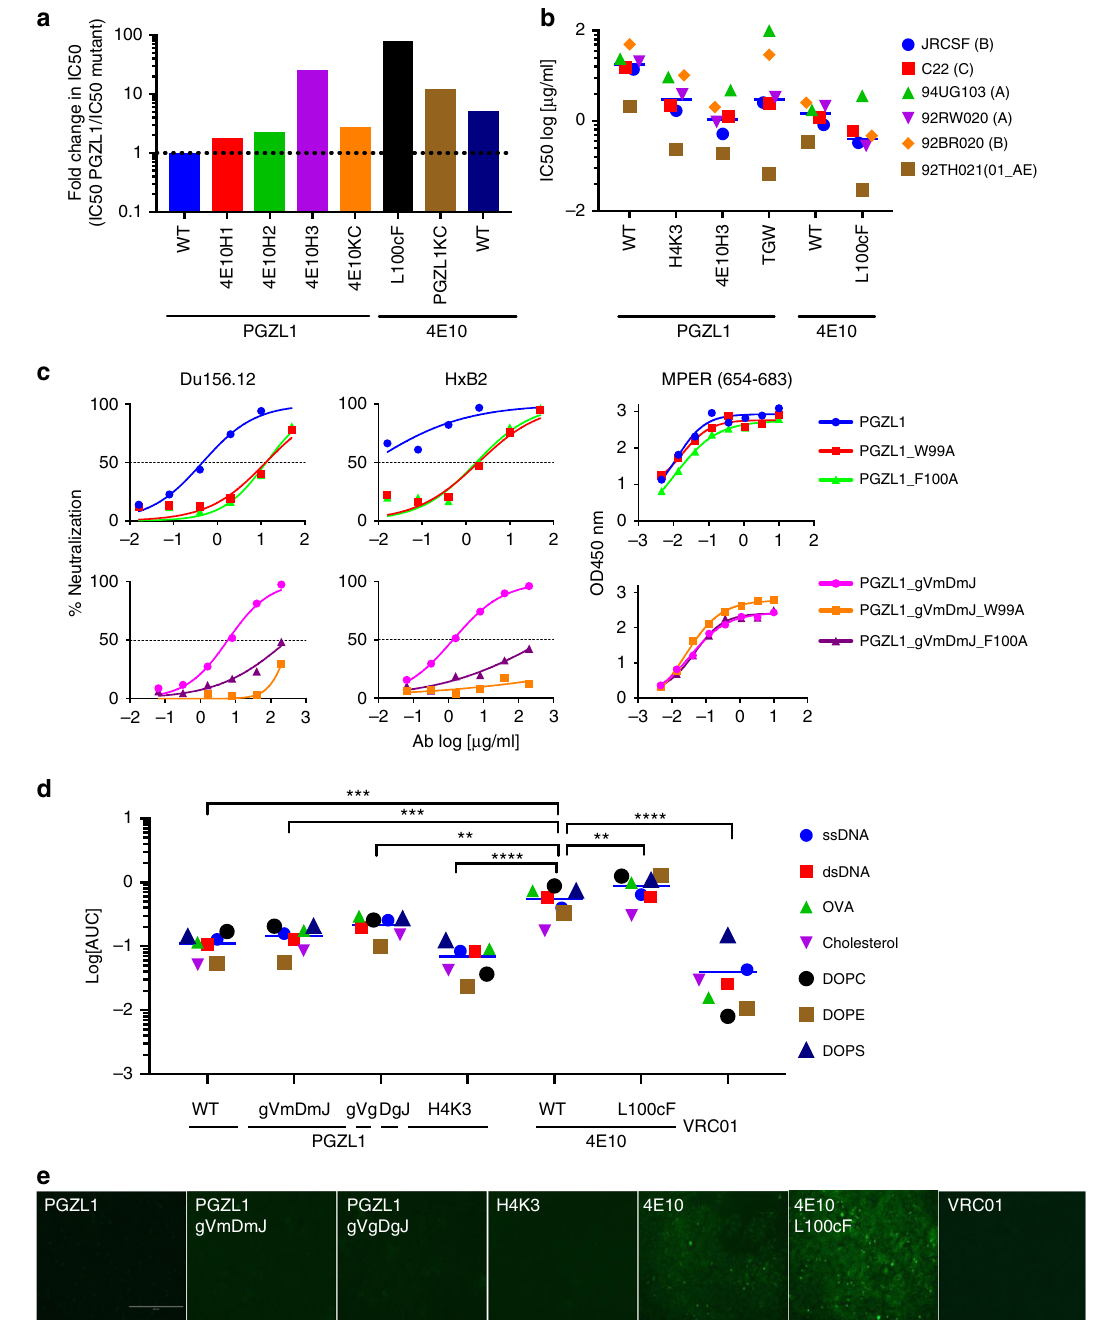
Fig. 3 Dominant role of CDRH3 in PGZL1 HIV-1 neutralization by D-gene-encoded residues. a Fold decrease in neutralization (IC 50 ) of isolate 92TH021 relative to wild-type PGZL1 by CDR grafts and LC substitution from 4E10 (left), and by 4E10 substitutions L 100c F and PGZL1 LC (right). b Neutralization (log IC 50 ) of a six-virus panel by PGZL1 and 4E10 variant antibodies. c Effect of Ala substitutions in D H -encoded residues W99 and F100 on the ability of PGZL1 mature (top panels) and inferred germline antibodies (bottom panels) to neutralize Du156.12 and HxB2 (left panels), as well as to bind MPER peptide in an ELISA (right panels). d Antibody polyreactivity in an ELISA as a function of area under the curve (AUC) of PGZL1 and 4E10 variant antibodies against nonspeci fi c antigens. VRC01 is a negative control. Two-way ANOVA multiple comparisons was used to compare the difference between groups ( n = 7, ** p = 0.0062, *** p = 0.0001, **** p < 0.0001). e Immuno fl uorescence staining of HEp-2 cells. Antibodies were tested at 50 μ g/ml using 4E10 and VRC01 as positive and negative controls, respectively; images are at ×200 magni fi cation and the scale bar is 400 µ m. Source data for b – d are provided as a Source Data fi